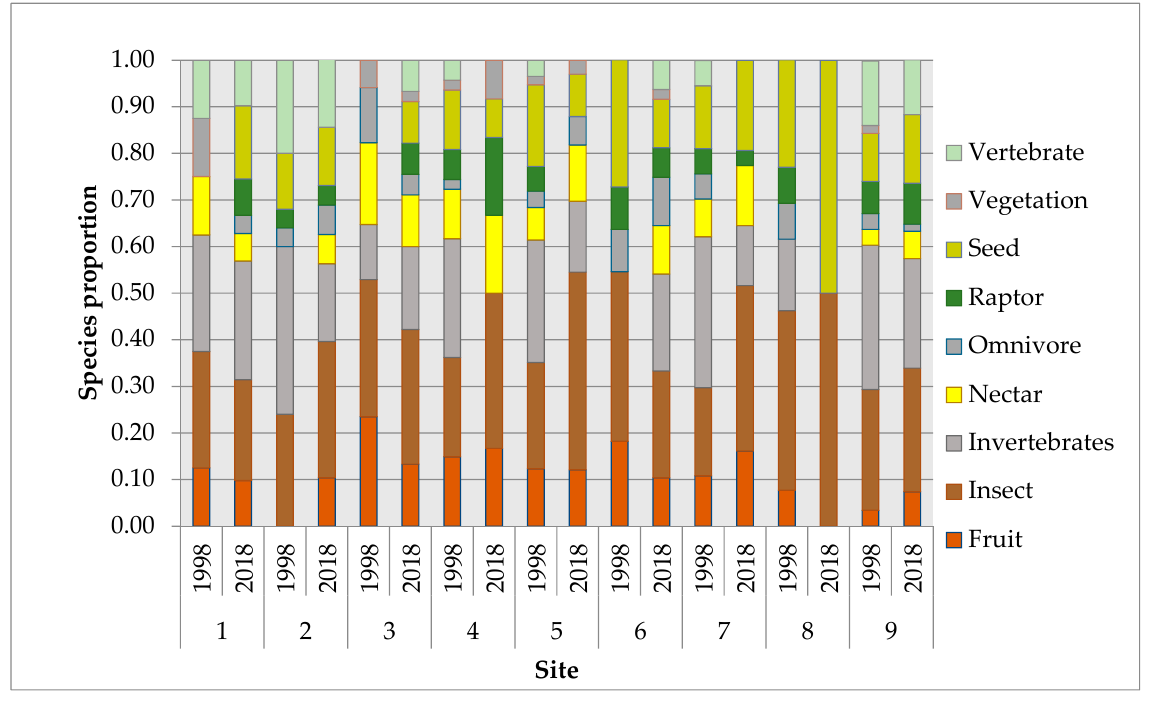
Figure 3. Proportion of species by primary food source at sites where urbanisation has increased.